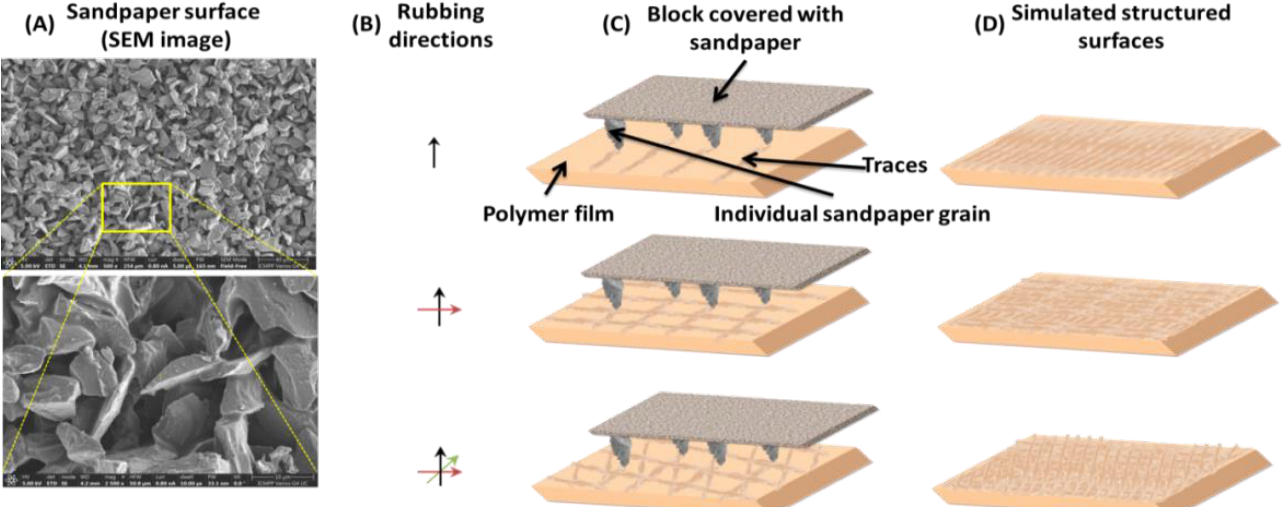
Figure 1. Illustration of the rubbing process: ( A ) SEM images of the sandpaper evidencing the individual grains layout and appearance. The yellow box represents the zone where the sandpaper was scanned at higher magnitude; ( B ) rubbing directions; ( C ) schematic representation of the rubbing device; ( D ) simulated structured polymer surfaces.